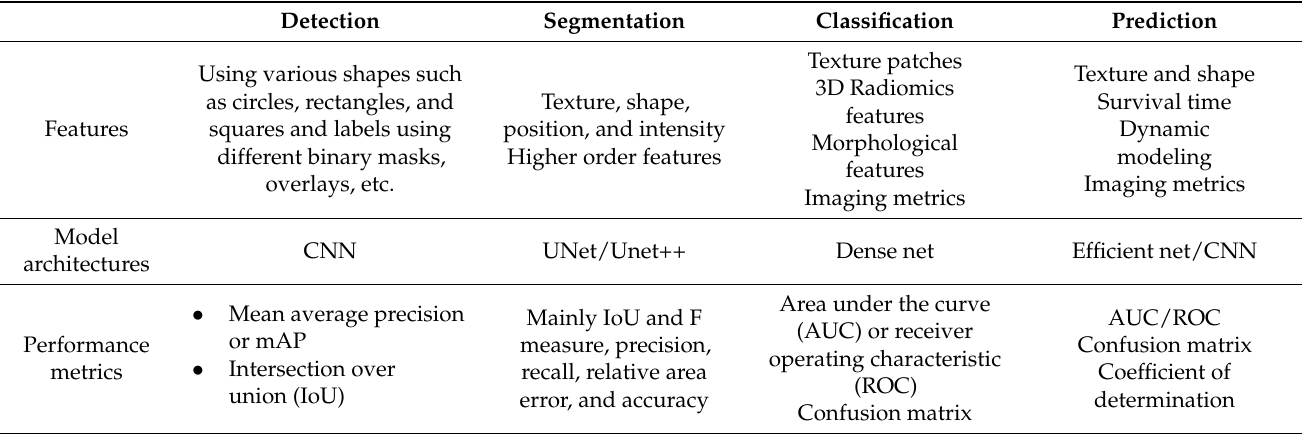
Table 3. General structures and common performance measurement metrics for various medical imaging-related tasks performed using SML